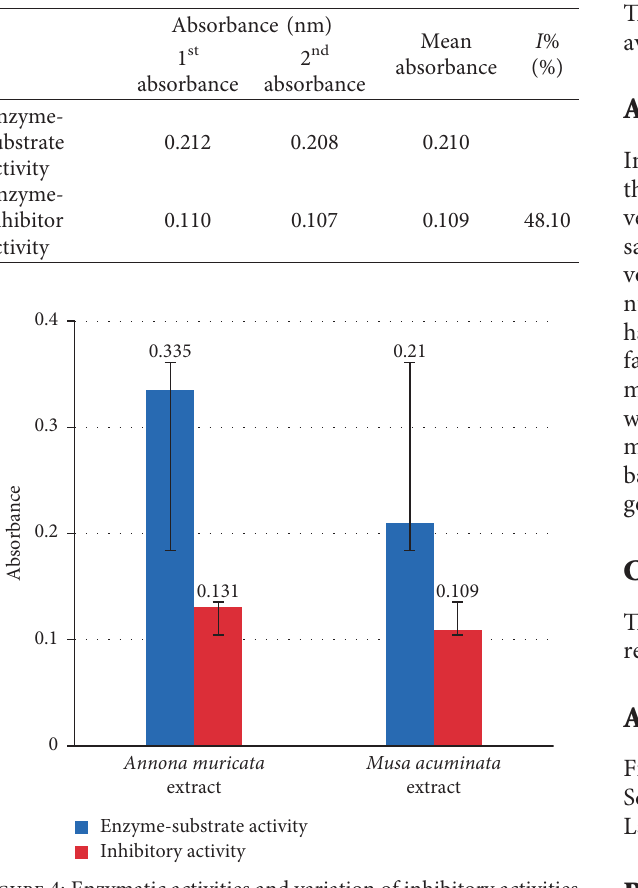
Table 4: Inhibitory activity of ginger on PPO activity of the Musa acuminata extract.